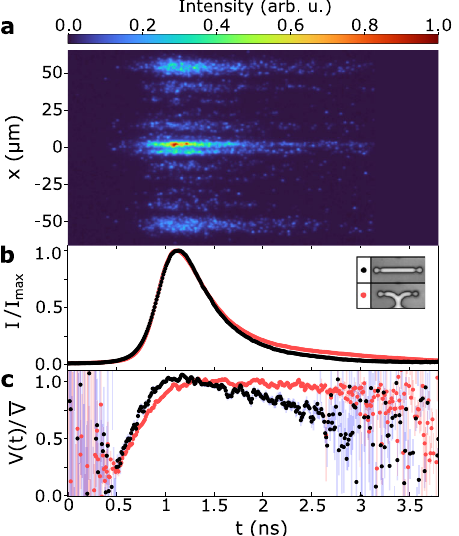
Fig. 4 Time-resolved coherence and condensate population for the direct and Y-coupler. a Streak camera image of a condensation process in the Y-coupler. This is a time-resolved measurement of the photon density along the cross section of the coupler. The central spot contains interference between both condensates, the visibility of these fringes over time is measured as V ( t ). Due to (shot) noise in the measurement, averaging over many pulses is required. We postselect the pulses to remove formation jitter and intensity fl uctuations. This leaves 247 and 757 out of 4000 images for the direct coupler and Y-coupler, respectively. b Averaged intensity envelopes of the direct coupler (black) and the Y-coupler (red), normalized to the maximum intensity. Both curves are very similar in envelope, the slightly longer tail in the pulse of the Y-coupler most likely stems from pump pulse fl uctuations present in a subset of all streak camera images. c Fringe visibility of the interference between the two condensates for the direct coupler (black) and Y-coupler (red), visibility is normalized to the time-averaged visibility of the integrated pulse. Error bars show the standard error for all data points.